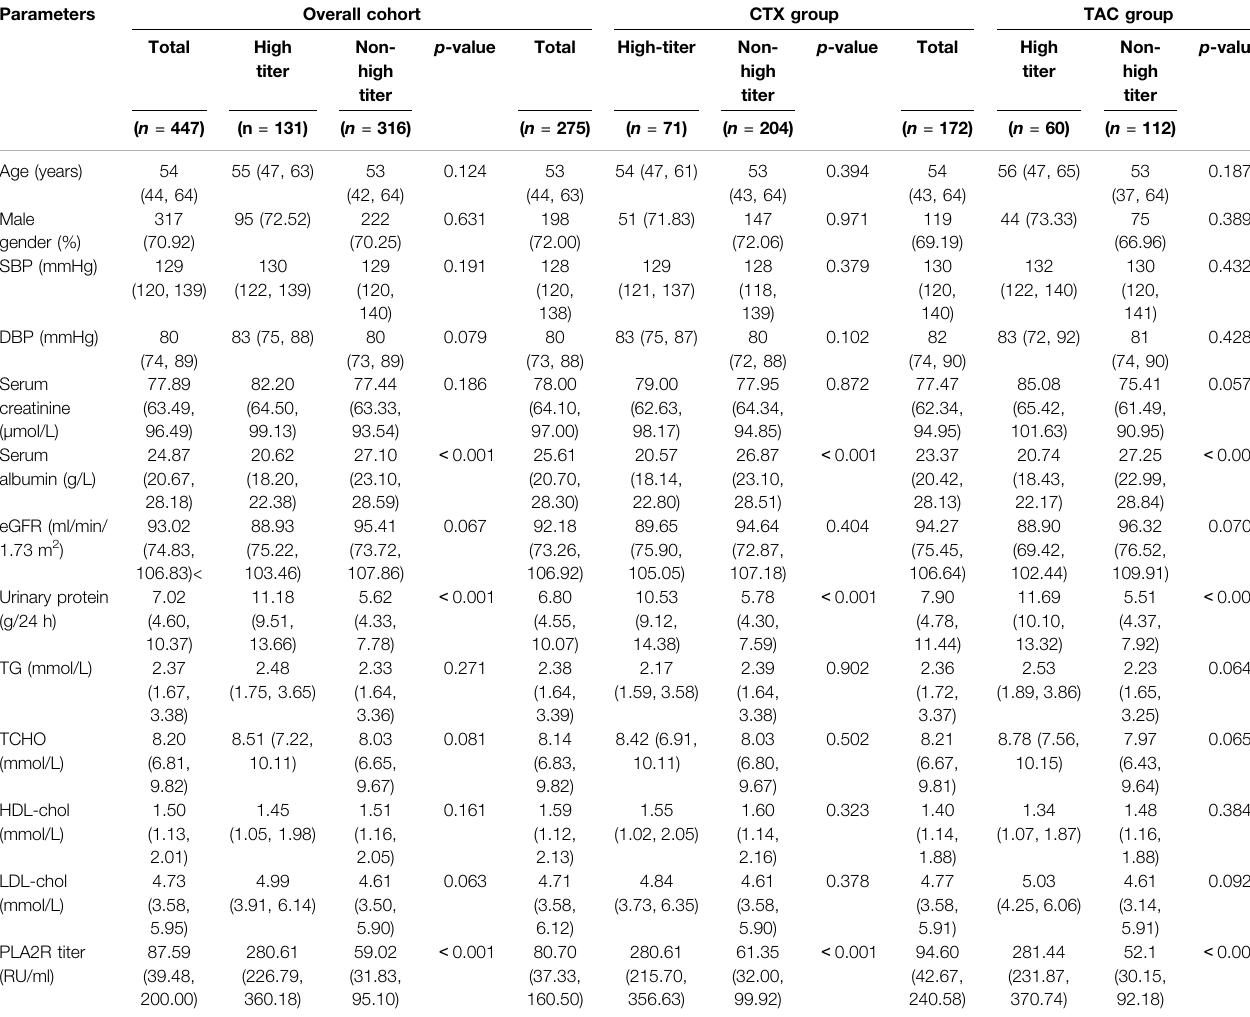
TABLE 1 | Comparison of baseline clinical characteristics between the two titer groups in overall cohort, CTX group, and TAC group. Parameters Overall cohort CTX group TAC